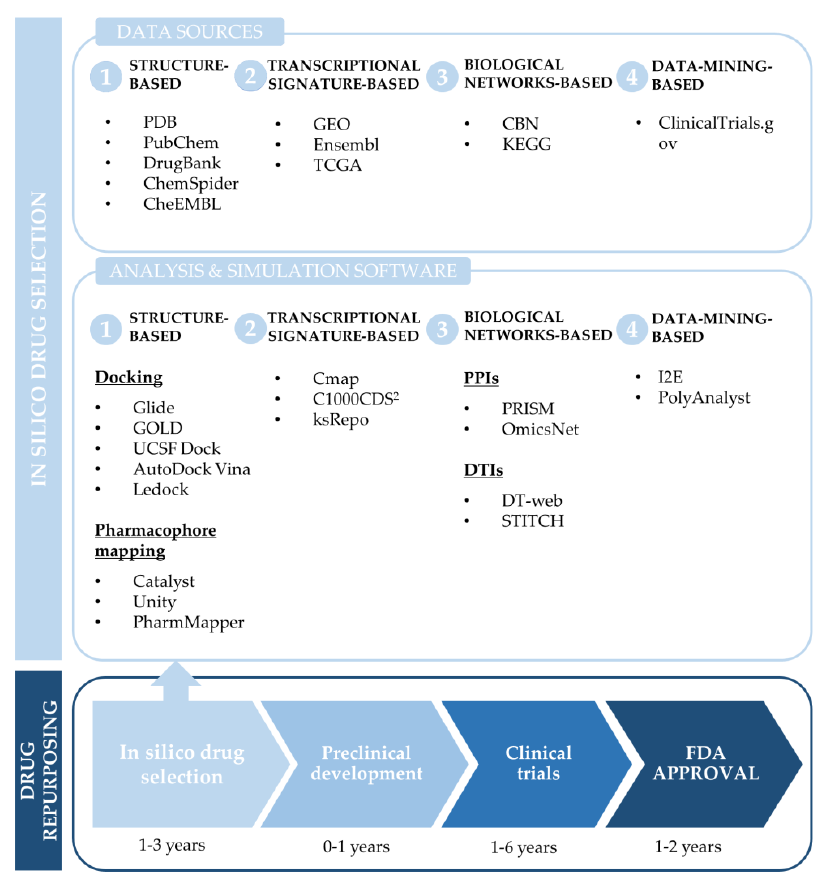
Figure 2. Diagram of the main computational approaches and software for drug repurposing.